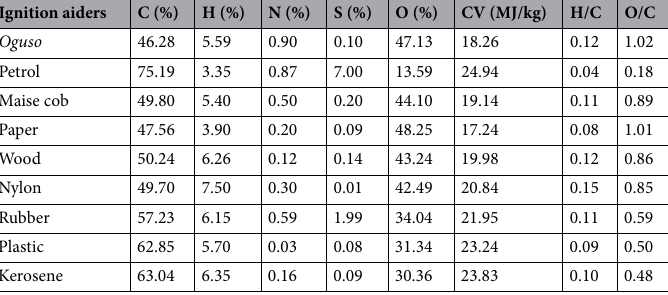
Table 5. Ultimate analysis of the ignition